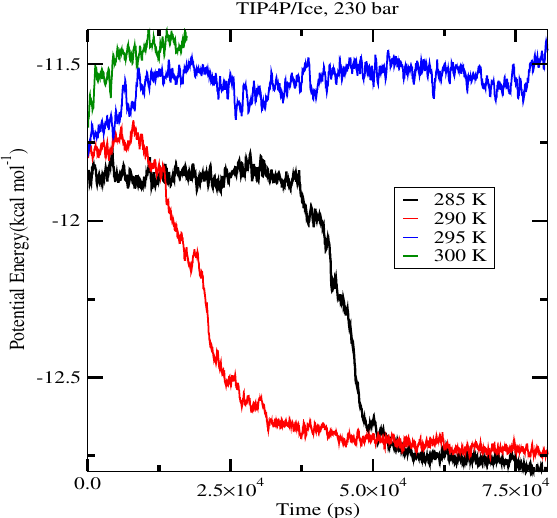
Figure 6. Evolution in time of the potential energy in simulations with the TIP4P/2005 model of the system in Figure 12.